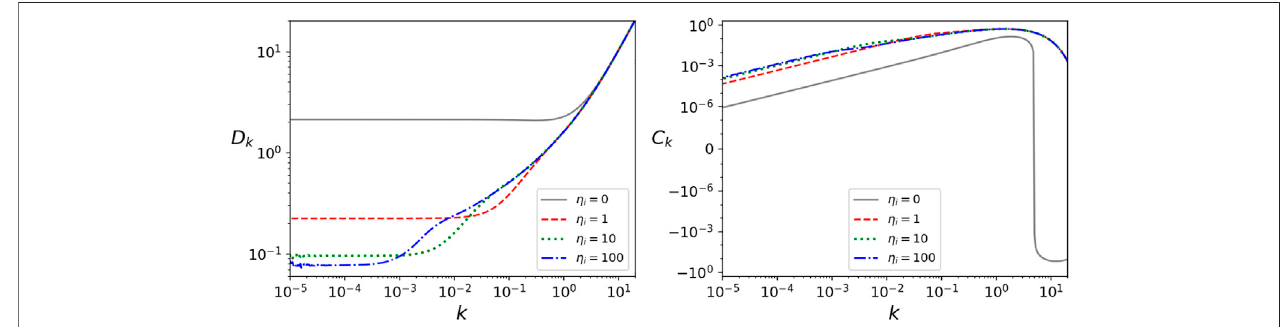
FIGURE 2 | Initial conditions in terms of D k and C k , as constructed in (8) , for scalar modes at the bounce corresponding to the SLEs obtained with the window function ( Eq. 15 ) covering the expanding branch until the onset of in fl ation with starting points: η 0 (cid:1) 0 (solid gray line), η 0 (cid:1) 1 (dashed red line), η 0 (cid:1) 10 (dotted green line) and η 0 (cid:1) 100(dotted-dashedblueline).Thescaleof k isinPlanckunits.Allcomputationswereperformedforaquadraticpotential V ( ϕ ) (cid:1) m 2 ϕ 2 /2,with m (cid:1) 1.2 × 10 – 6 and with the value of the scalar fi eld at the bounce fi xed to ϕ B (cid:1) 1.225 (toy value). For tensor modes, the resulting SLE at the bounce shows no signi fi cant qualitative differences.